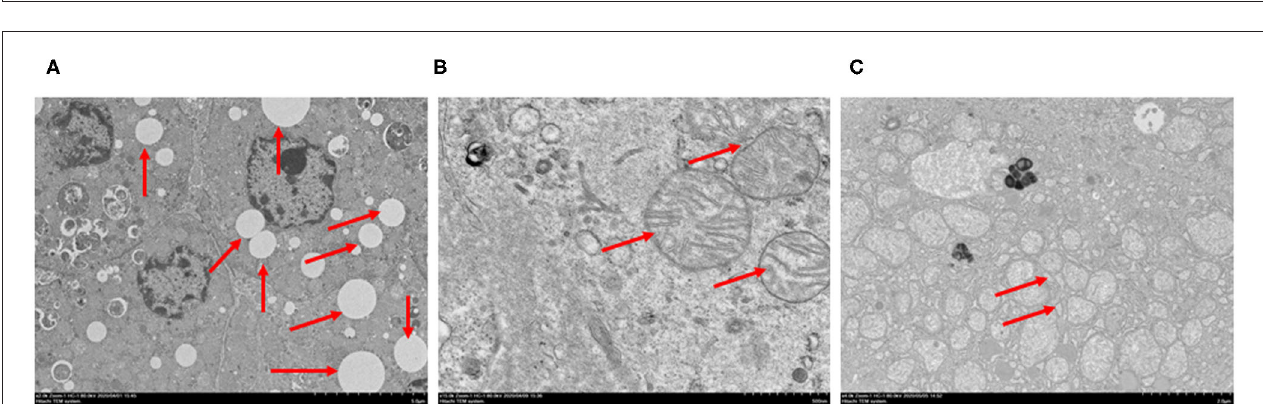
FIGURE 1 | Spectrum of pathologic abnormalities of liver tissues from postmortem of patients with COVID-19. (A) swelling of the hepatocytes, (B) cholestasis, (C) steatosis, (D) hepatocellular necrosis. (E) lobular inflammation, (F) portal inflammation, (G) fibrosis, (H) dilatation of sinusoids, Bars = 50 µ m (A–D) .